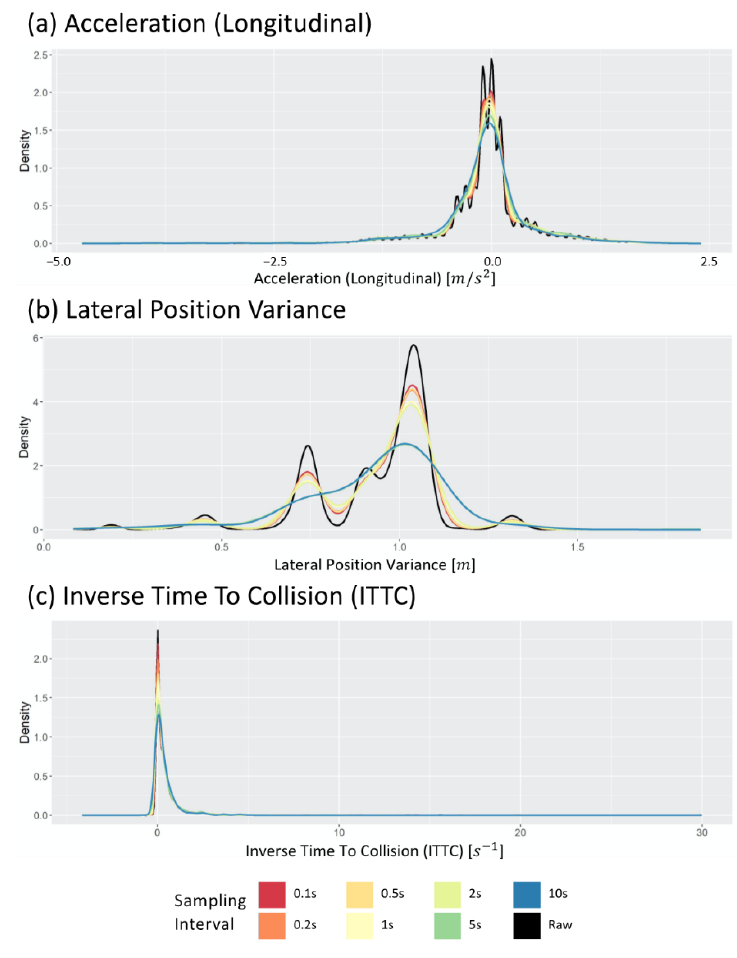
Figure 4. Change in distribution of ( a ) the longitudinal acceleration, ( b ) lateral position variation, and ( c ) inverse time to collision varying sampling intervals.